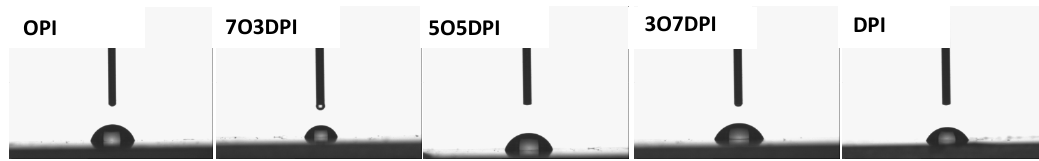
Figure 5. Images of water contact angle test of polyimide films.